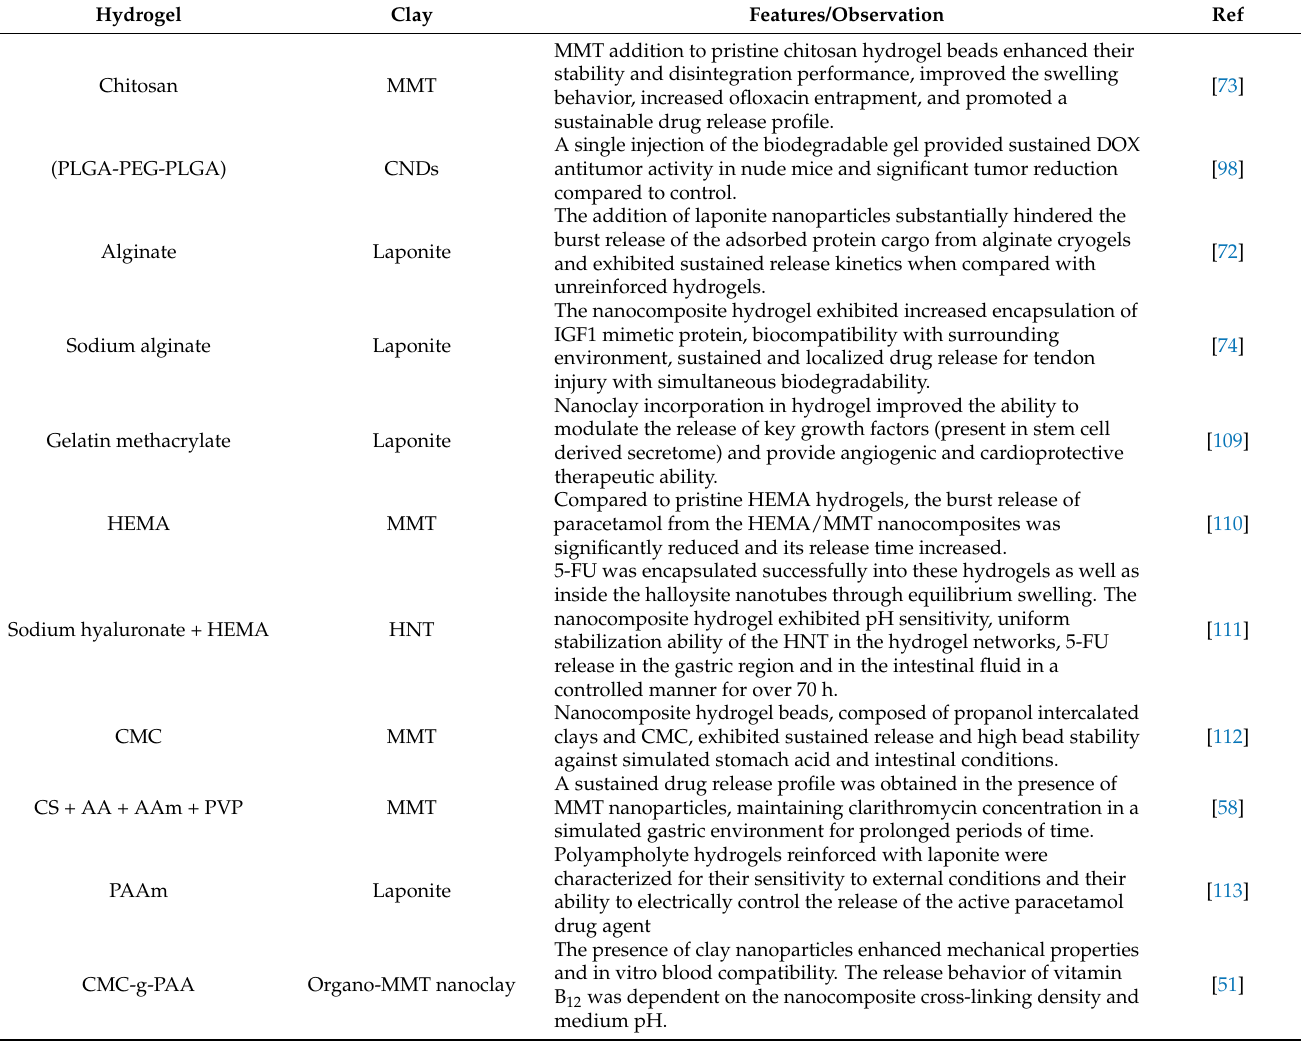
Table 4. Clay nanoparticles in hydrogel nanocomposites for drug delivery